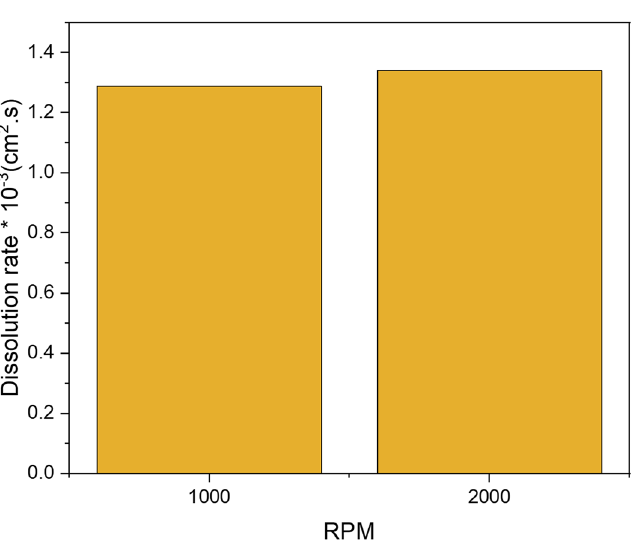
Figure 11. Effect of disc rotational speed on pyrite dissolution in DTPAK 5 10 wt. % + K 2 CO 3 9 wt. %